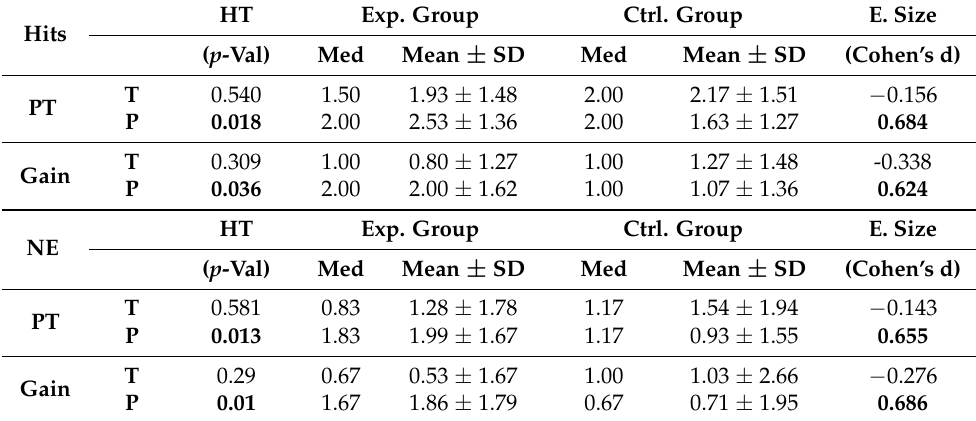
Table 2. Statistical analysis of the post-test and the gain for the 10-item instrument. The first part of the table (Hits) uses the hits rating while the second one (NE) uses the null-expectation rating.